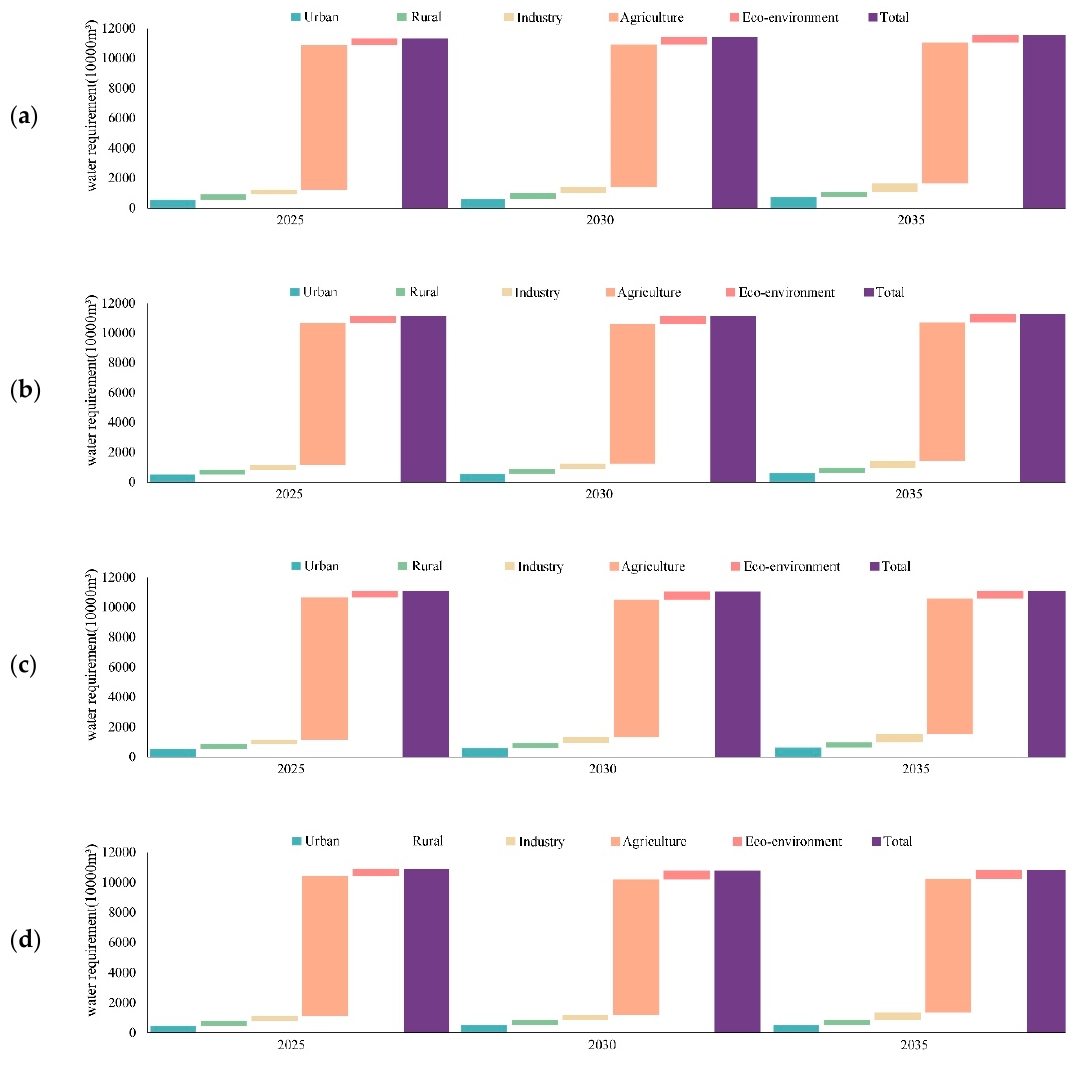
Figure 9. Prediction results of water demand in different industries under different scenarios: ( a ) High growth and moderate water-saving scenario; ( b ) Moderate growth and moderate water-saving scenario; ( c ) High growth intensifies water-saving scenario; ( d ) Moderate growth intensifies water-saving scenario.